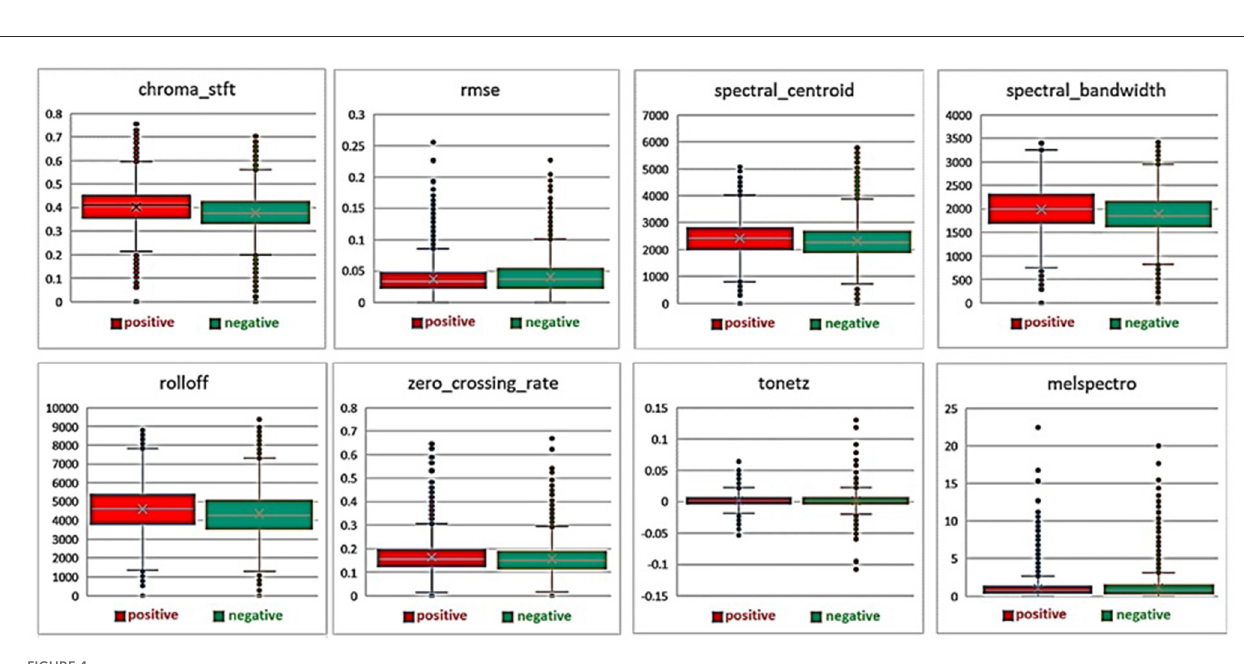
FIGURE4 Average, minimum and maximum values of features extracted from healthy and diseased